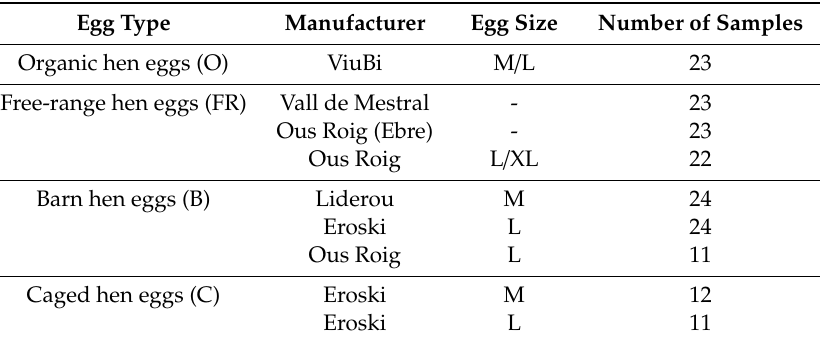
Table 1. Description of the egg samples